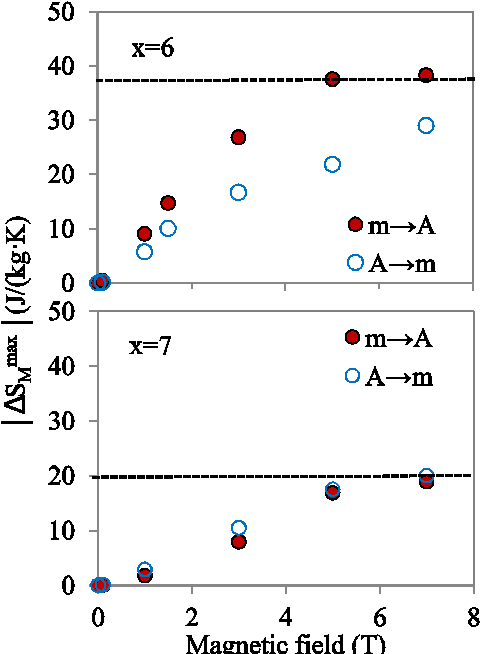
(cid:12) (cid:12) (cid:12) (cid:12) (cid:12) ∆ S max M (cid:12) , as a function of